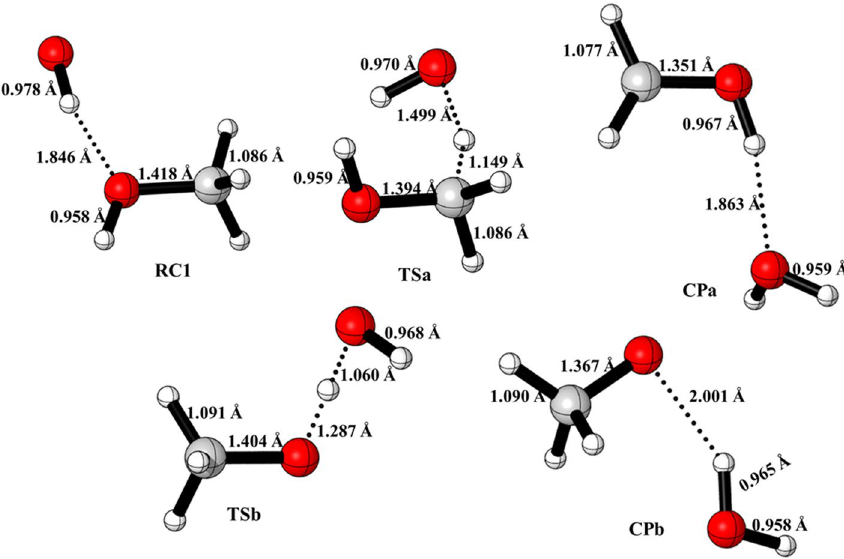
Figure 2. Structural and geometrical changes during OH + CH 3 OH reaction calculated using M06-2X/6- 311++G(3df,3pd). These structures were generated from CYLview software.